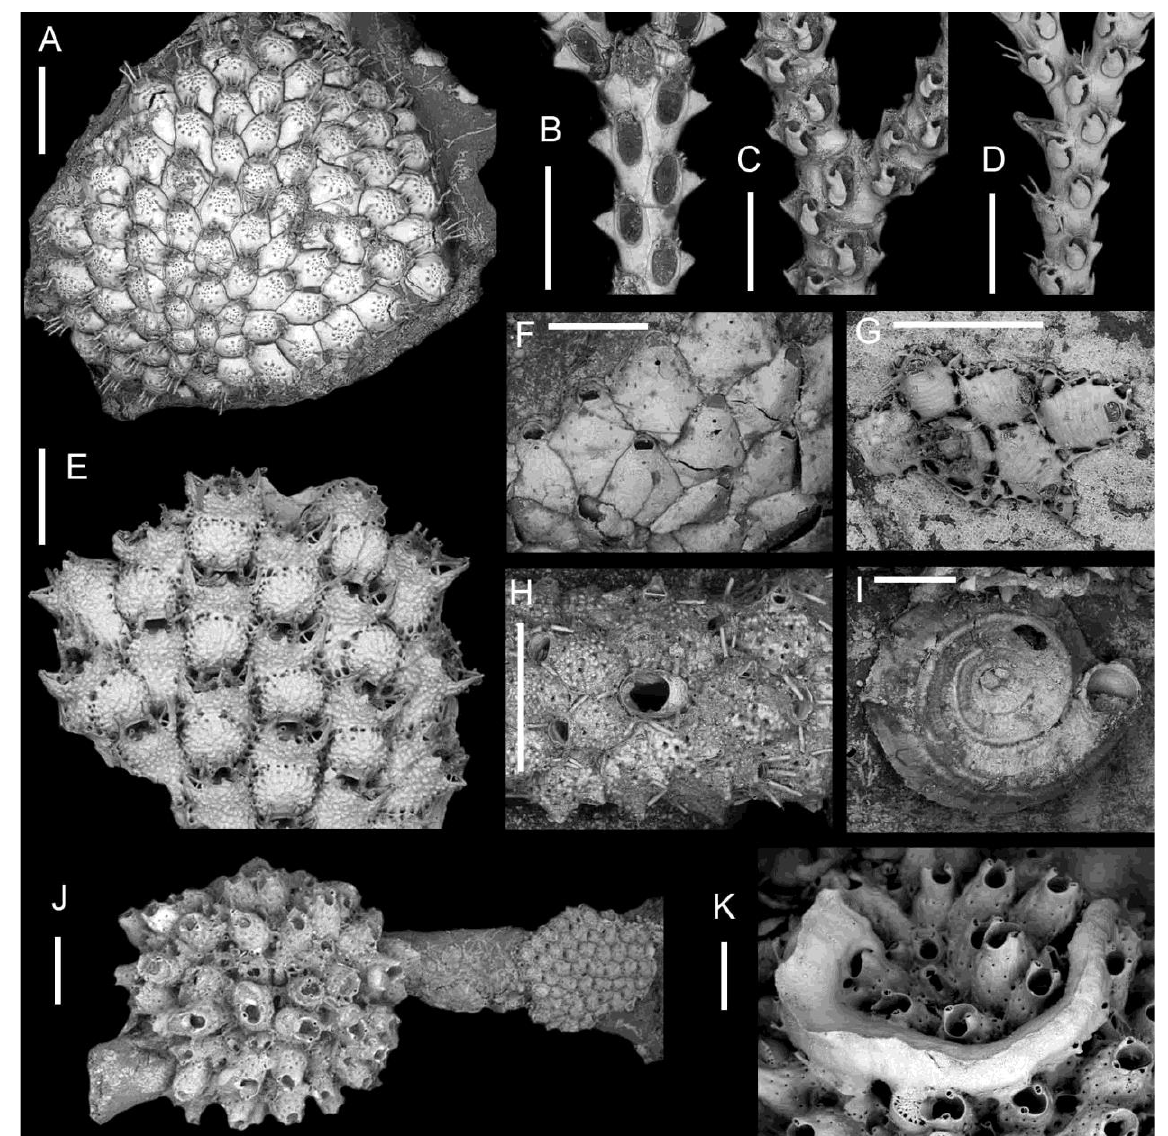
Figure 7. SEM images of bryozoans and a serpulids epibiont on the canopy of the E Build-up collected offshore of Marzamemi (Ionian Sea). ( A ): Puellina gattyae on a fleshy alga. PMC. Rosso Collection I. H. B-105a. (Scale bar: 500 μ m). ( B ) Scrupocellaria scruposa PMC. Rosso Collection I. H. B-106a. (Scale bar: 500 μ m). ( C ) Scrupocellaria delilii , PMC. Rosso Collection I. H. B-107a. (Scale bar: 500 μ m). ( D ) Scrupocellaria cf. incurvata . PMC. Rosso Collection I. H. B-108a. (Scale bar: 500 μ m). ( E ) Escharoides mamillata detached from Flabellia petiolata . PMC. Rosso Collection 109a. (Scale bar: 500 μ m). ( F ) Haplopoma cf. impressum on F. petiolata . PMC. Rosso Collection I. H. B-110a. (Scale bar: 500 μ m). ( G ) Chorizopora brongniartii on Peyssonnelia rubra . PMC. Rosso Collection I. H. B-99a2. (Scale bar: 500 μ m). ( H ) Microporella modesta on M. cereoides . PMC. Rosso Collection I. H. B-86f. (Scale bar: 500 μ m). ( I ) Neodexiospira pseudocorrugata on F. petiolata . PMC. Sanfilippo Collection I. H. Pol. 5a2. (Scale bar: 500 μ m). ( J ) Celleporina caminata and Cribrilaria hincksi on a F. petiolata stem. PMC. Rosso Collection I. H. B-70b. (Scale bar: 500 μ m). ( K ) Small specimen of Spirobranchus triqueter on Celleporina caminata . PMC. Rosso Collection I. H. B-98a3. (Scale bar: 500 μ m).